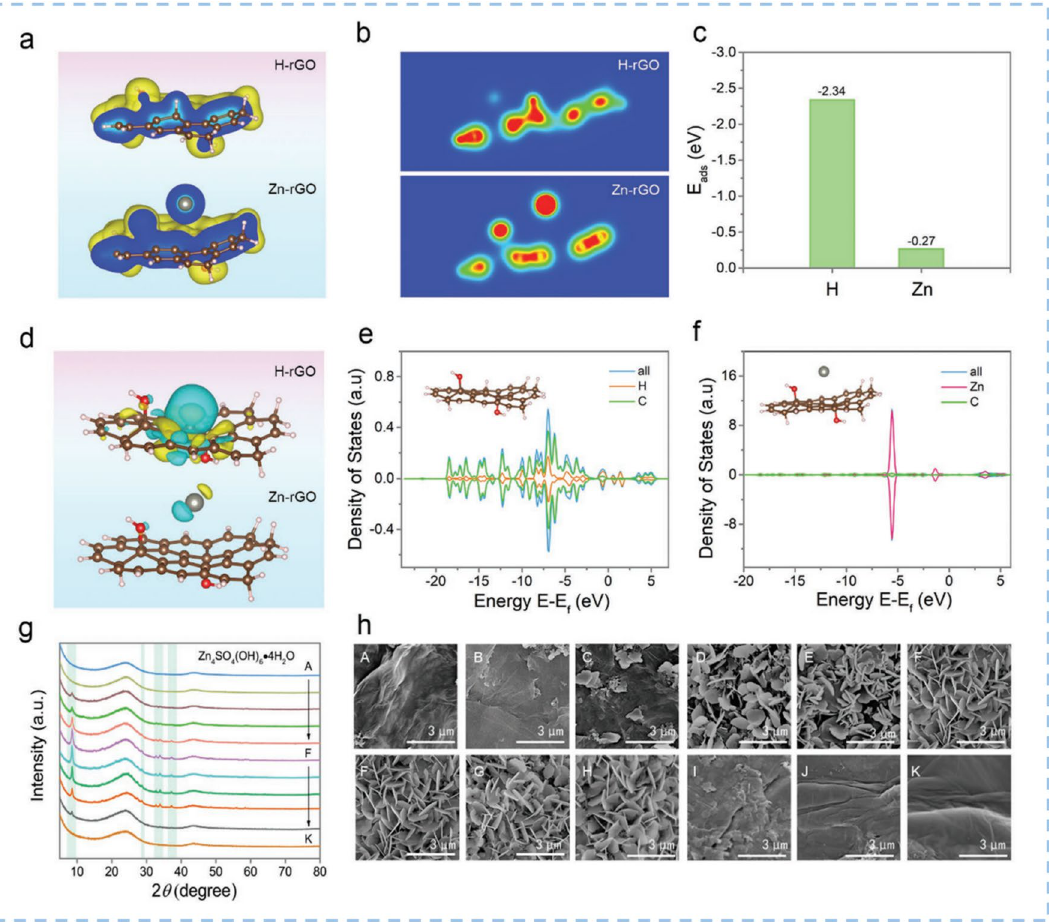
Fig. 8 DFT calculation and ex situ SEM to verify the adsorption process of H + ions on rGO. a The structure energy and b charge distribution of rGO-200 upon adsorption of H + and Zn 2+ . c The calculated adsorption energy of H + and Zn 2+ on rGO. d The optimized charge-density- difference patterns and e , f density of the states of rGO model upon the adsorption of H + and Zn 2+ ions. g , h Ex situ XRD profiles and situ SEM images of rGO-200. Reproduced with permission [144]. Copyright 2022,